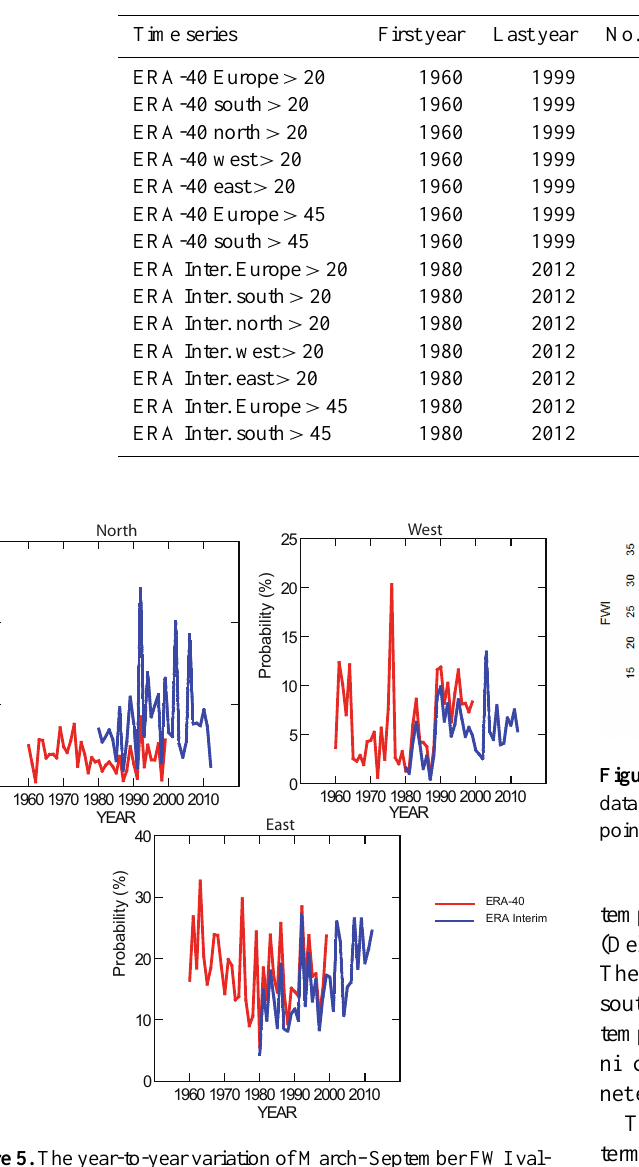
Figure 5. The year-to-year variation of March–September FWI val- ues above 20 from ERA-40 and ERA Interim data sets calculated for north, west and east. Values are expressed as a probability (Eq. 1).